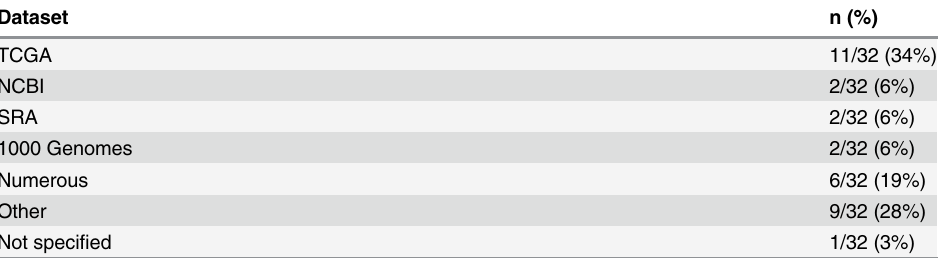
Table 2. Publicly available NGS datasets used for analysis ( Current Users